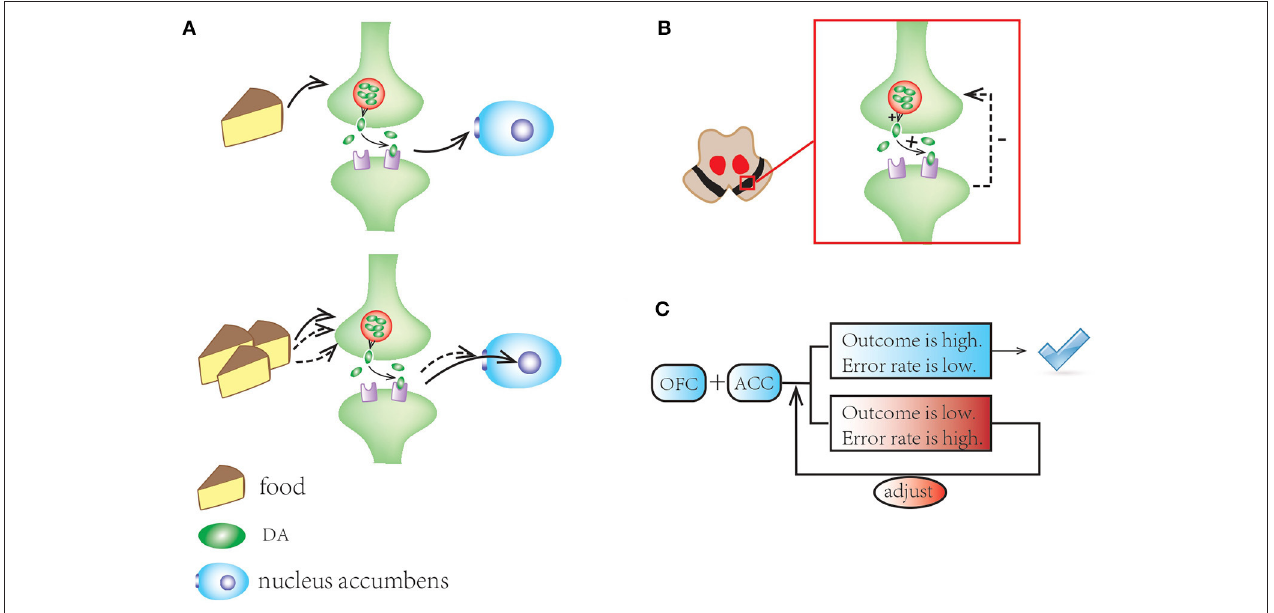
FIGURE 3 | A schematic illustration of mesocorticolimbic network and reward system. (A) Standard stimuli (e.g., food) motivate tonic dopamine response in the outer shell of the nucleus accumbens; repeated stimuli induce habitation with the response shifting to its core. (B) In substantia nigra, dopamine autoreceptors offer feedback to regulate synaptic dopamine concentrations. (C) The OFC and ACC make adjustments for optimizing future choices and balance the system.